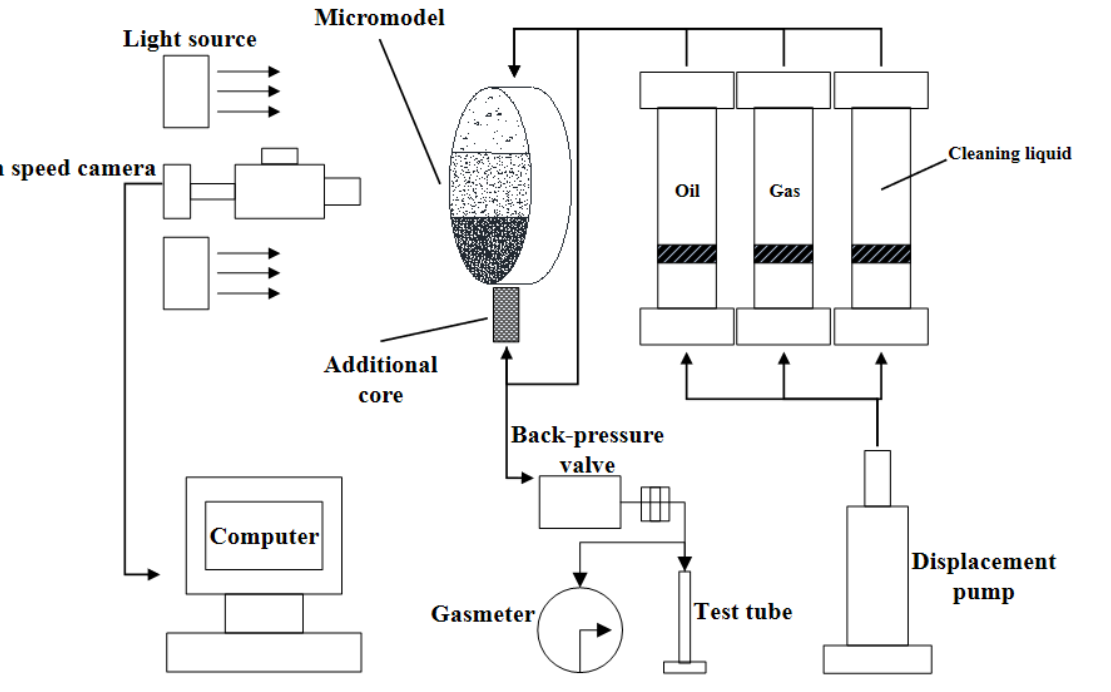
Figure 3. High-temperature and high-pressure microscopic visual oil displacement device.